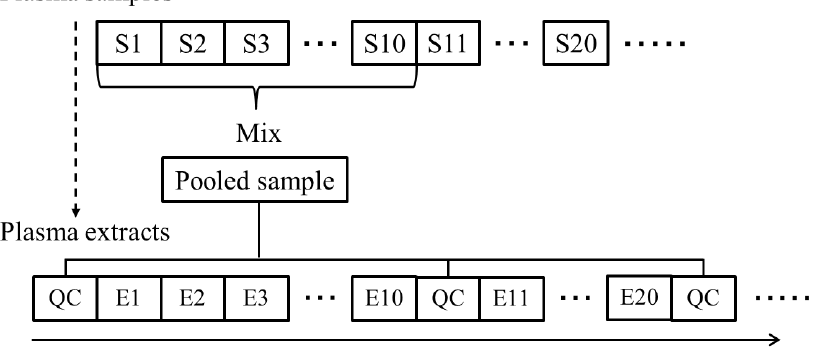
Figure 8. Overview of the procedure for preparation of pooled quality control (QC) samples and the measurement sequence for all samples, including the actual samples for each individual and QC samples. The letter “ S ” stands for samples and “ E ” for extracts.